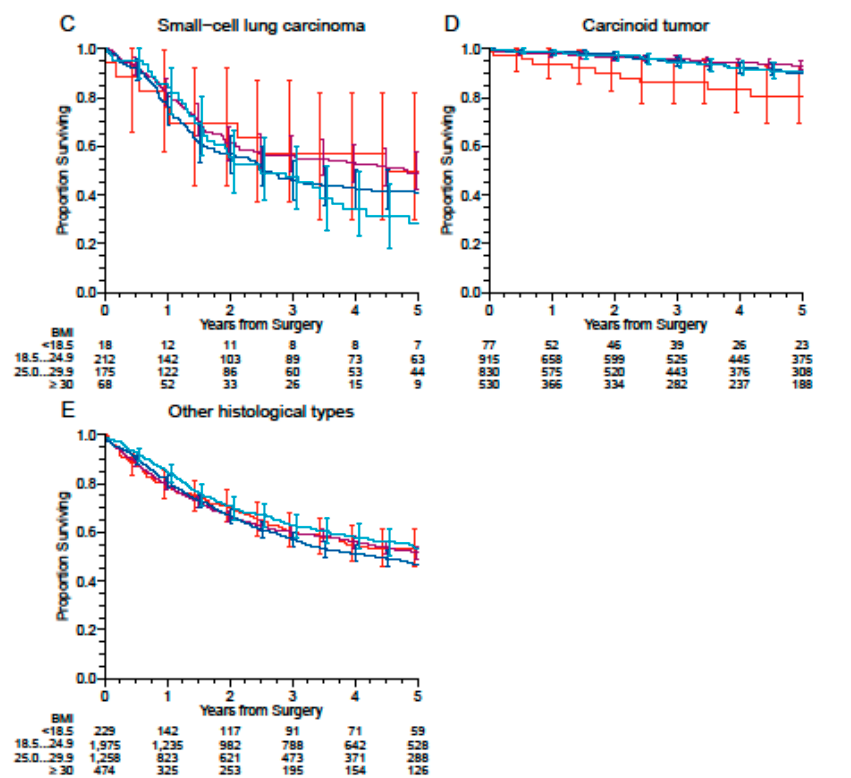
Figure 6. Survival according to obesity categories in different histologic types: ( A ) Adenocarcinoma, ( B ) Squamous-Cell Carcinoma; ( C ) Small-cell carcinoma; ( D ) Carcinoid tumors (typical and atypical); ( E ) Others. Obesity classes are defined as class 1: BMI 30.0–34.9, class 2: BMI 35.0–39.9 and class 3: BMI ≥ 40.0.